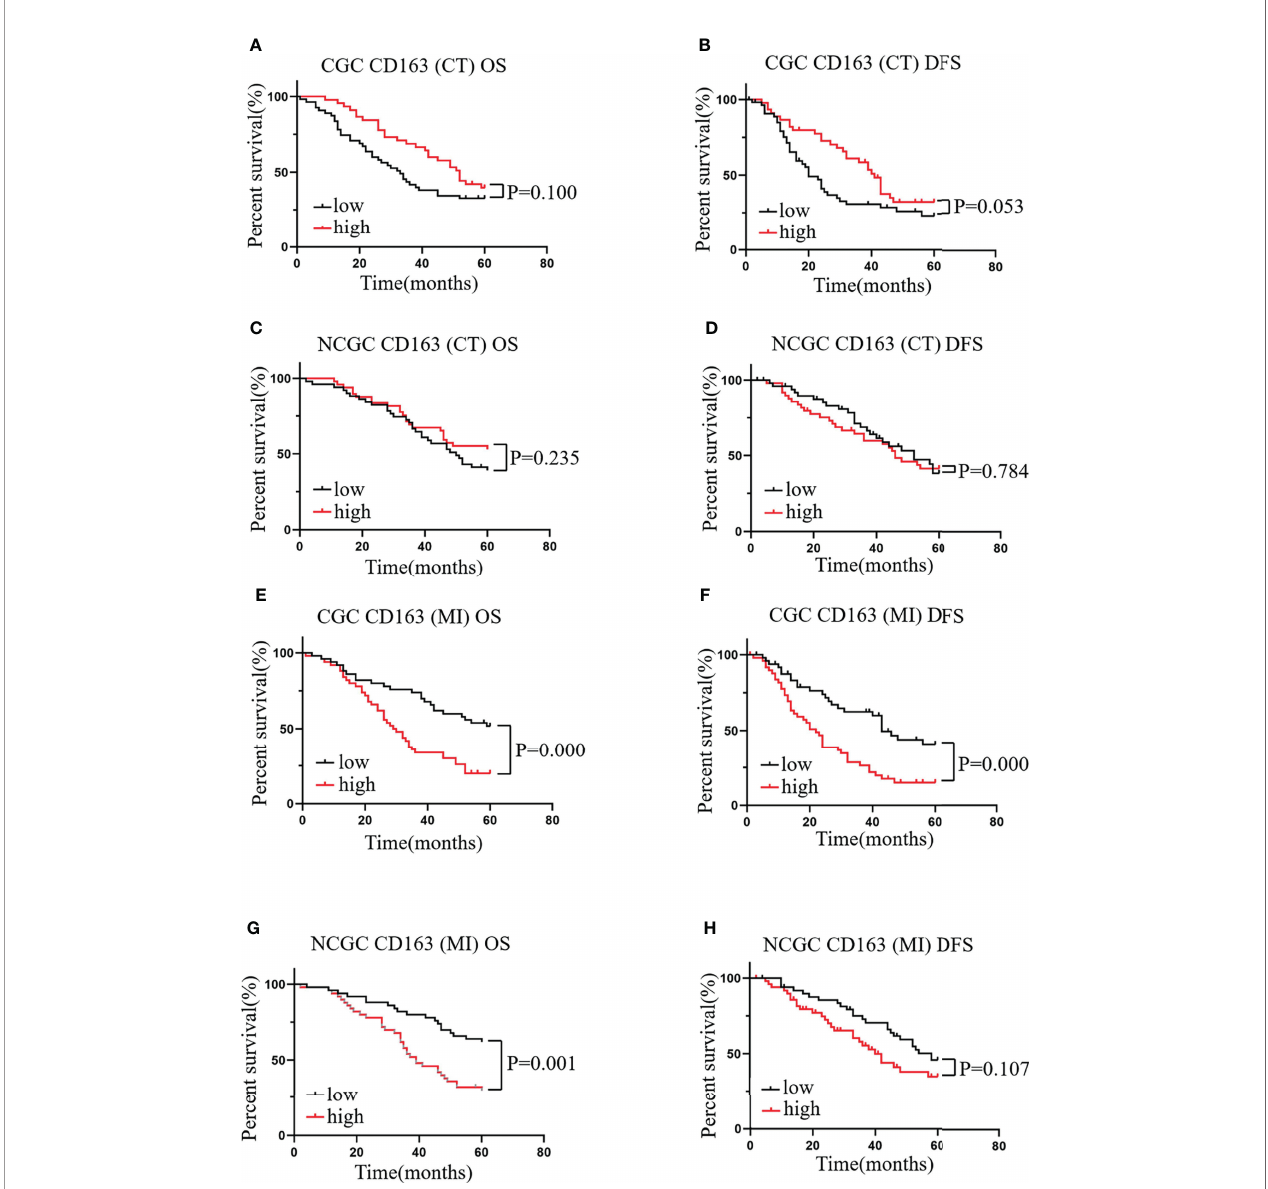
FIGURE 3 | The relationship between CD163 + macrophages in different locations and prognosis and clinicopathological features of patients with CGC and NCGC. A higher number of CD163 + macrophages at the CT was not correlated with OS or DFS in CGC (A, B) or NCGC (C, D) . (E, F) A higher number of CD163 + macrophages at the MI was associated with poor OS and DFS in CGC. (G, H) A higher number of CD163 + macrophages at the MI was closely correlated with poor OS in NCGC, while DFS was not. CT, core of primary tumors; MI, invasive margin of primary